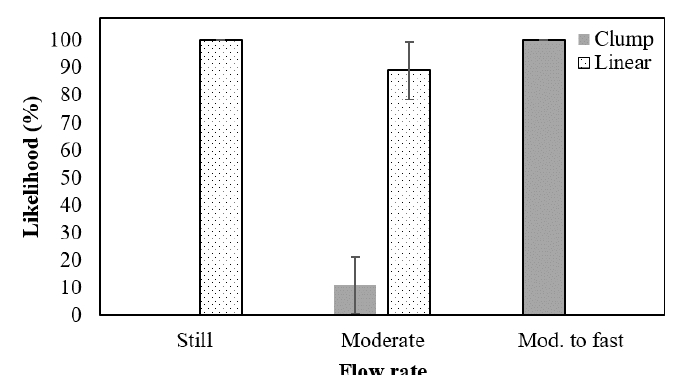
Figure 8: The association between the flow rate and type of the population of C. furcata in the mainstream.